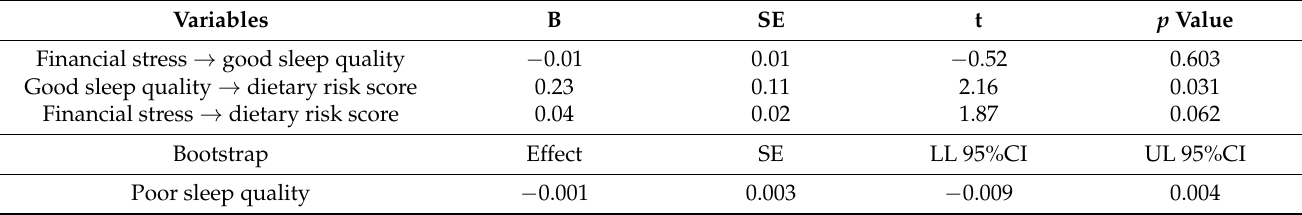
Table 7. Model 3 Mediation Analysis among Students with Good Sleep Quality.